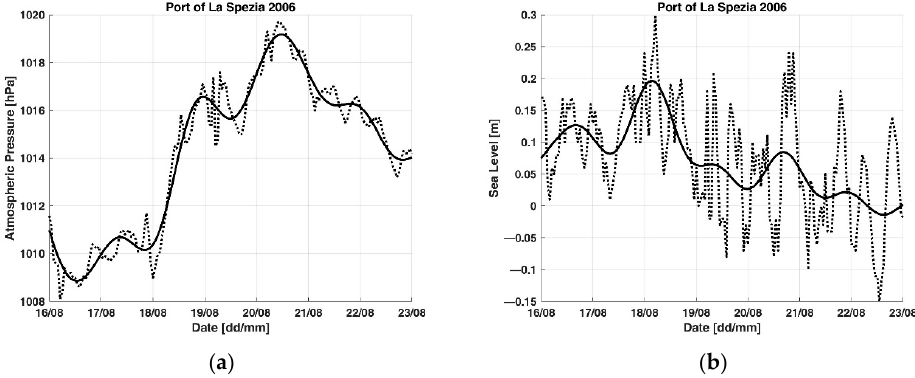
Figure A2. Measurements carried out between 16 and 23 August 2006 inside the port of La Spezia: ( a ) atmospheric pressure; ( b ) sea level ( Δ p = 10.3 hPa, Δ h = 21 cm, J ph = 2 cm * hPa − 1 ).